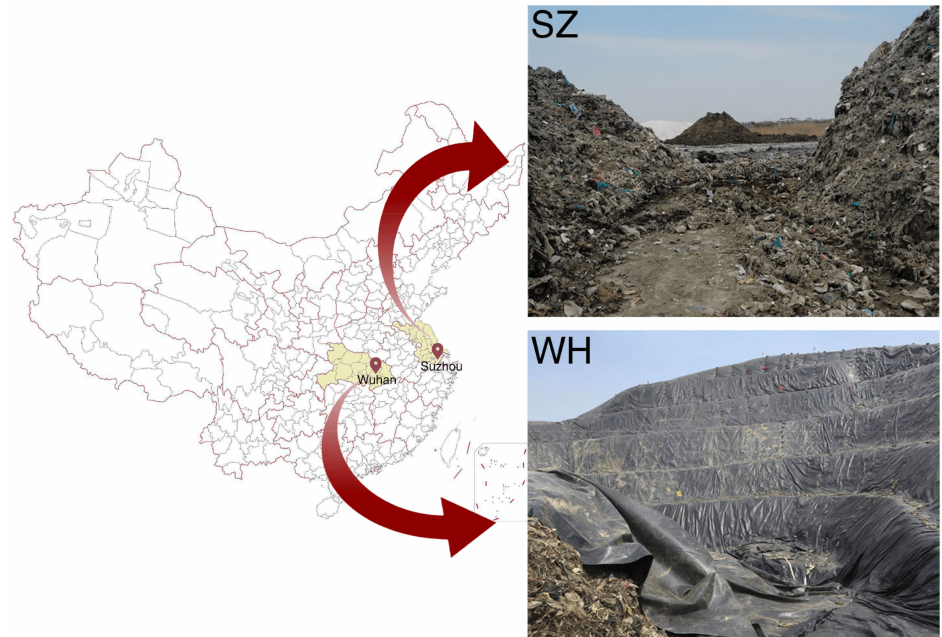
Figure 1. The geographical location of two sampling landfills. Suzhou landfill (SZ) and Wuhan landfill (WH) in